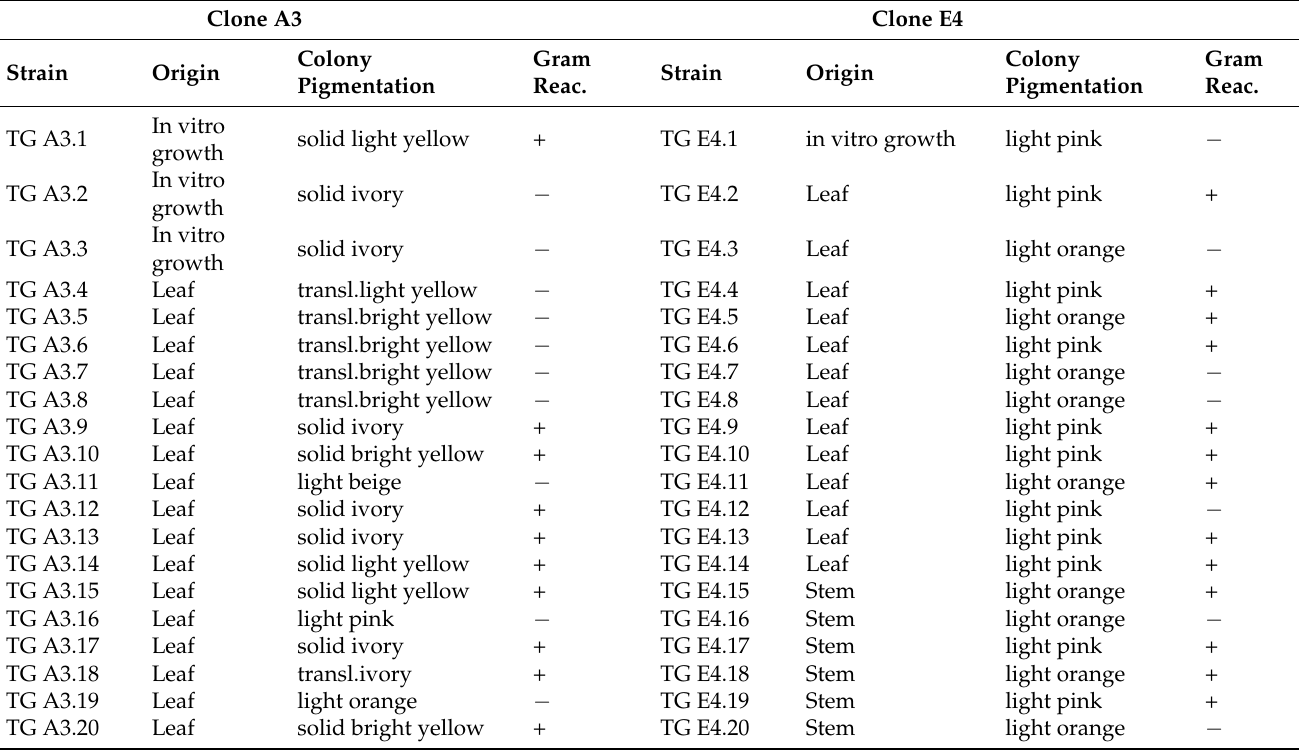
Table 2. Bacteria strains, origin, color pigmentation, gram reaction from endogenous bacteria of A3 and E4